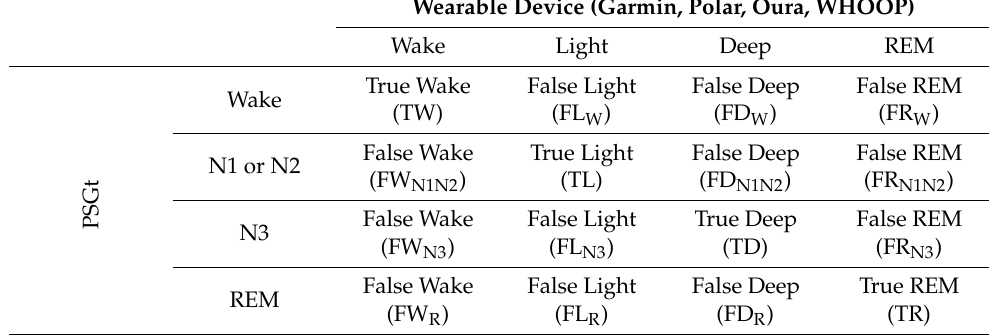
Table 2. Sleep stage agreement